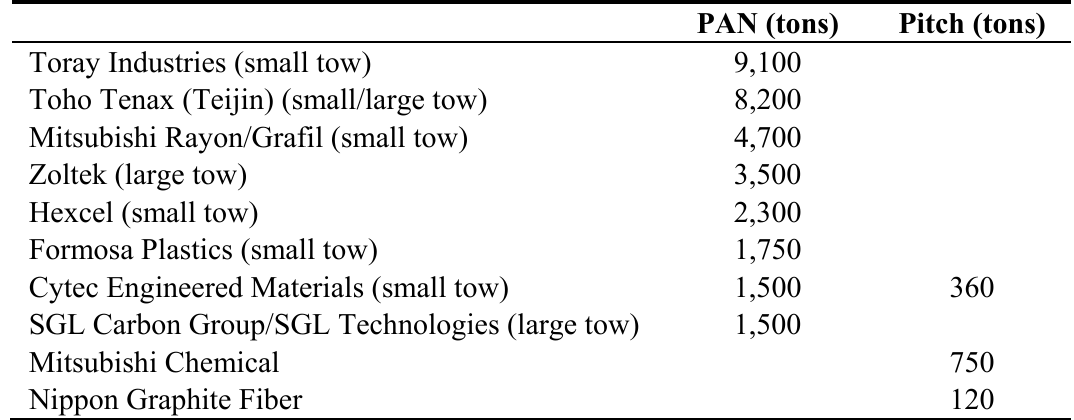
Table 2. Estimated name plate carbon fiber capacity in 2005